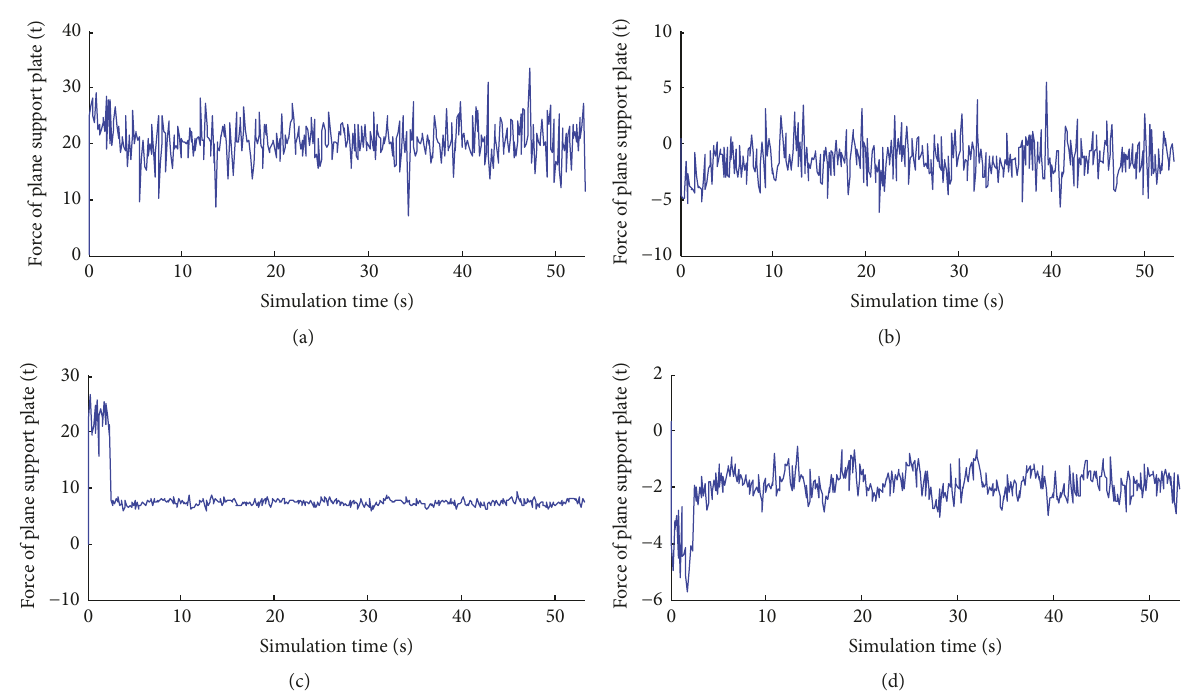
Figure 3: Time histories of forces acting on plane support plate pin shafts. (a) Force along the 𝑌 direction on the left plane support plate pin shaft, (b) force along the 𝑍 direction on the left plane support plate pin shaft, (c) force along the 𝑌 direction on the right plane support plate pin shaft, and (d) force along the 𝑍 direction on the right plane support plate pin